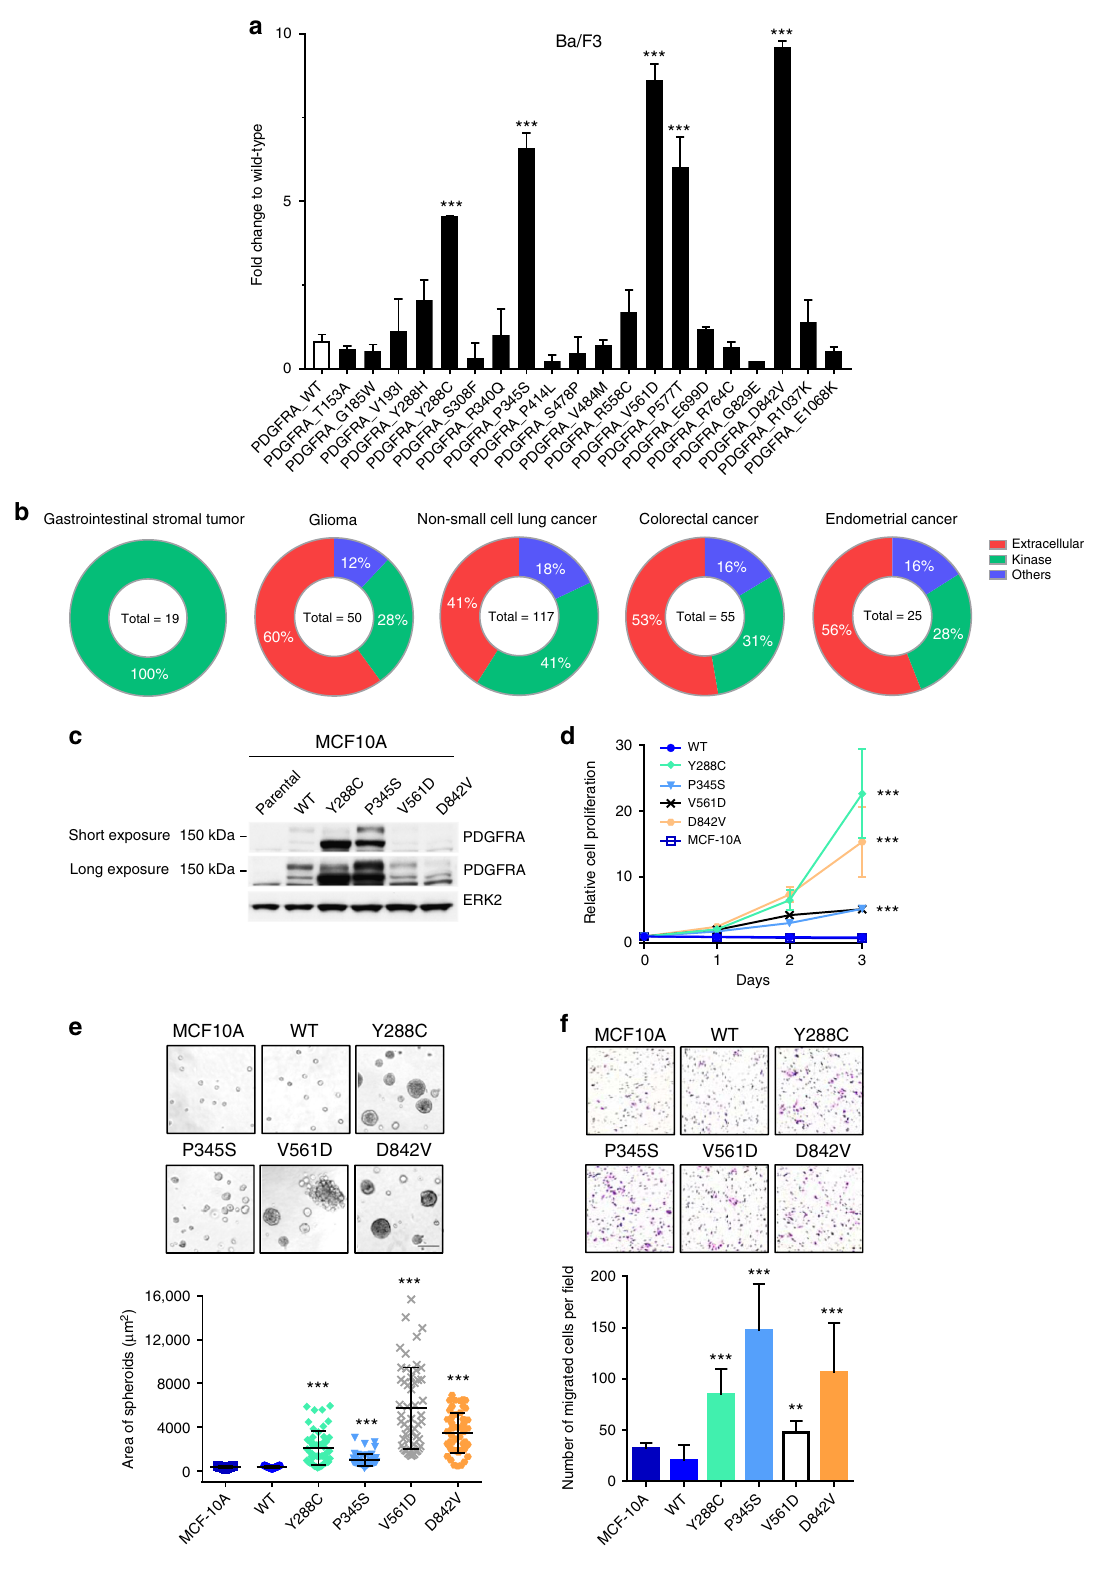
the mutations. Further, based on the 3D structural location, none of the mutations on the surface of the extracellular domain was activating, while 3 out of 7 of surface mutations on the kinase domain were activating (Supplementary Table 1), suggesting that surface mutations on the kinase domain might have a higher